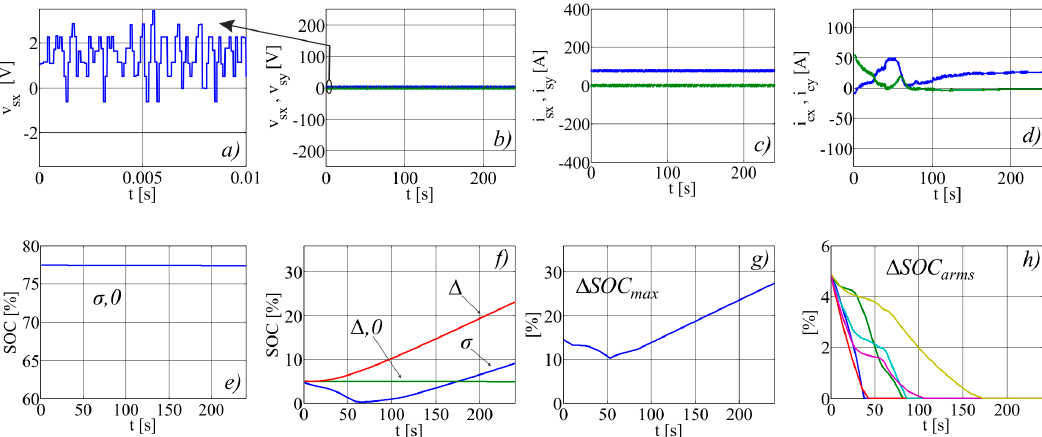
Figure 5. Numerical results for zero speed: ( a ) zoom of x motor voltage component; ( b ) x,y motor voltage components; ( c ) x,y motor current components; ( d ) x,y circulating current components; ( e ) half of the zero-sequence component of the arms sum SOCs; ( f ) unbalance SOC terms; ( g ) difference between the maximum and the minimum SOC of all cells; and, ( h ) difference between the maximum and the minimum SOC of the six arms.